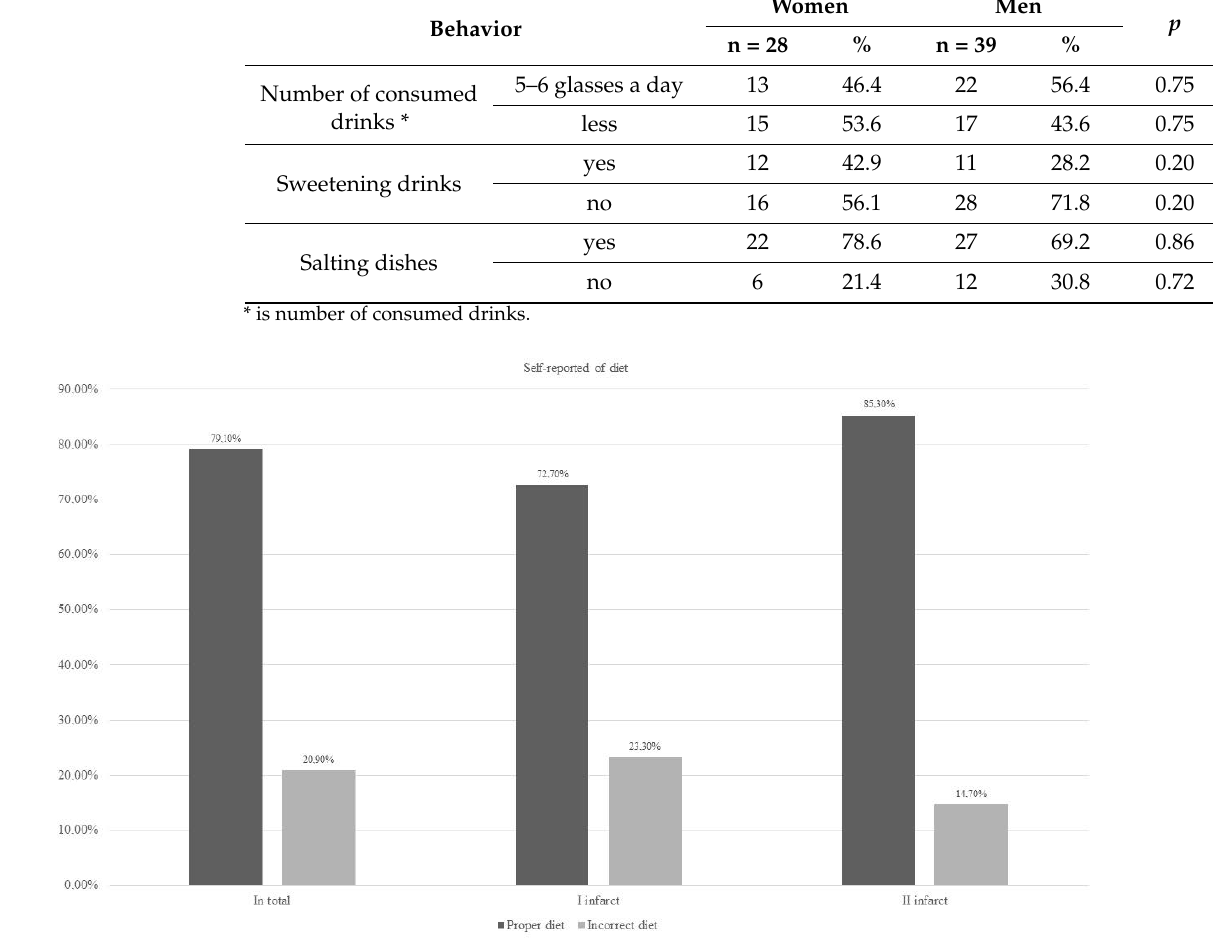
Figure 1. Self-reported diet in the study group of patients in total and by MI history (n = 67).